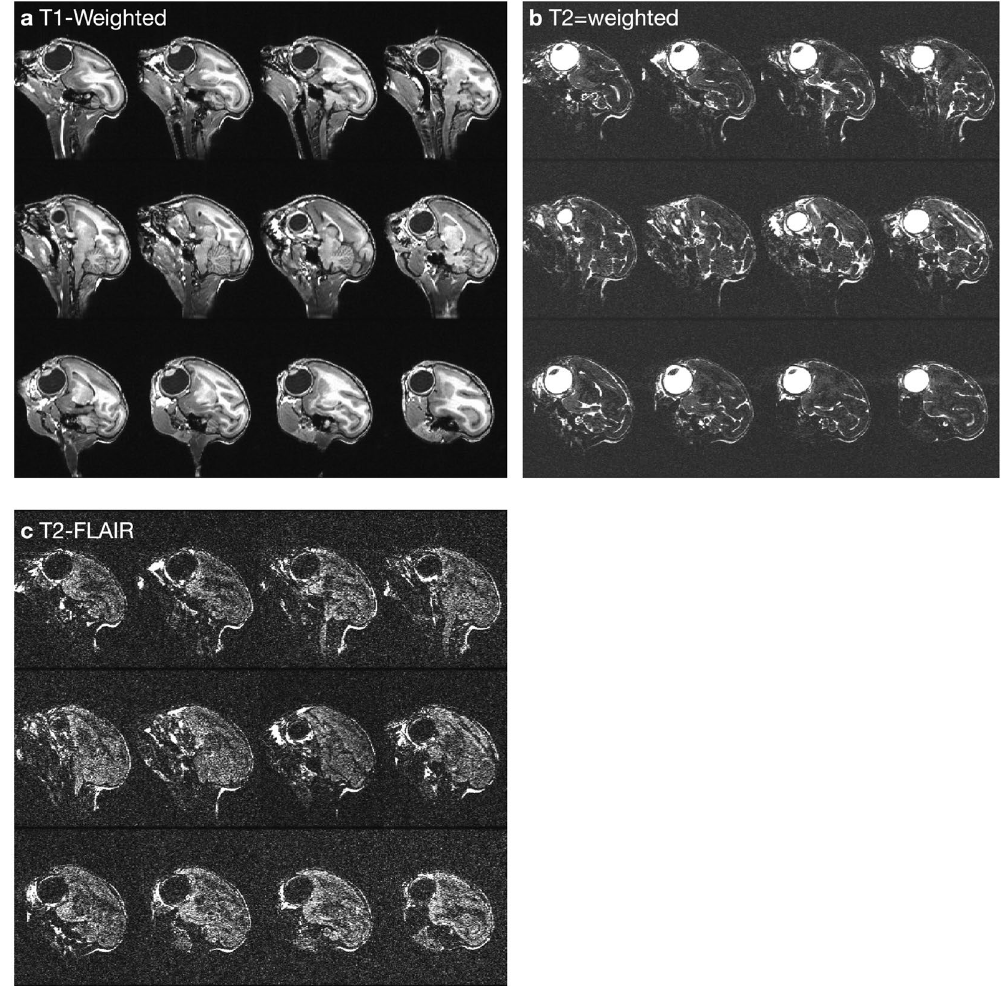
EYFP in Right S1. Three types of coronal scans were acquired per monkey and reformatted in the sagittal plane for visualization: ( a ) T1-weighted 3D IR-FSPGR sequence which maximizes gray-white matter contrast, ( b ) T2-weighted fast spin echo (FSE), and ( c ) T2-weighted fluid-attenuated inversion recovery (FLAIR) sequences which are used to identify potential brain pathology. Upon review by a clinical neuroradiologist,